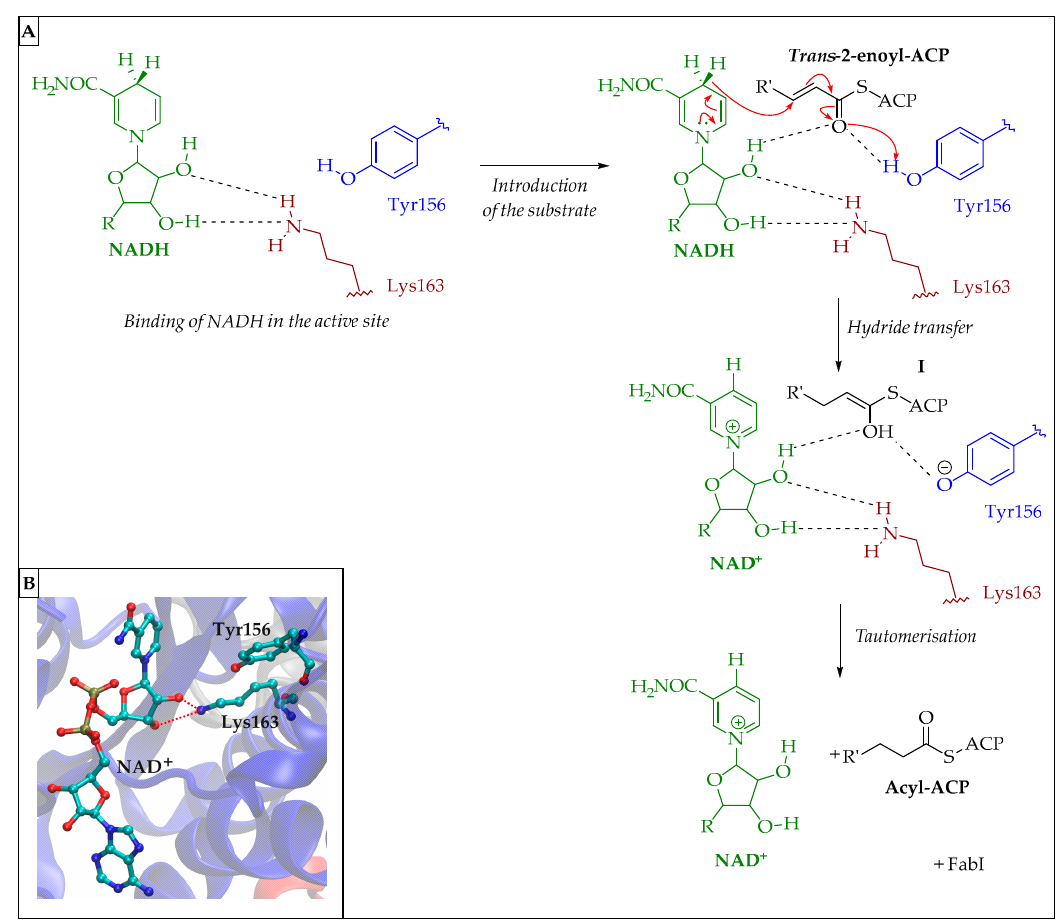
Figure 25. ( A ) Scheme of the mechanism of the reduction catalysed by Ec FabI. ( B ) View of the active site of Ec FabI-NAD + structure (PDB ID 1DFI) highlights the hydrogen bonds between the hydroxy groups of NAD + and Lys163 (red dots).